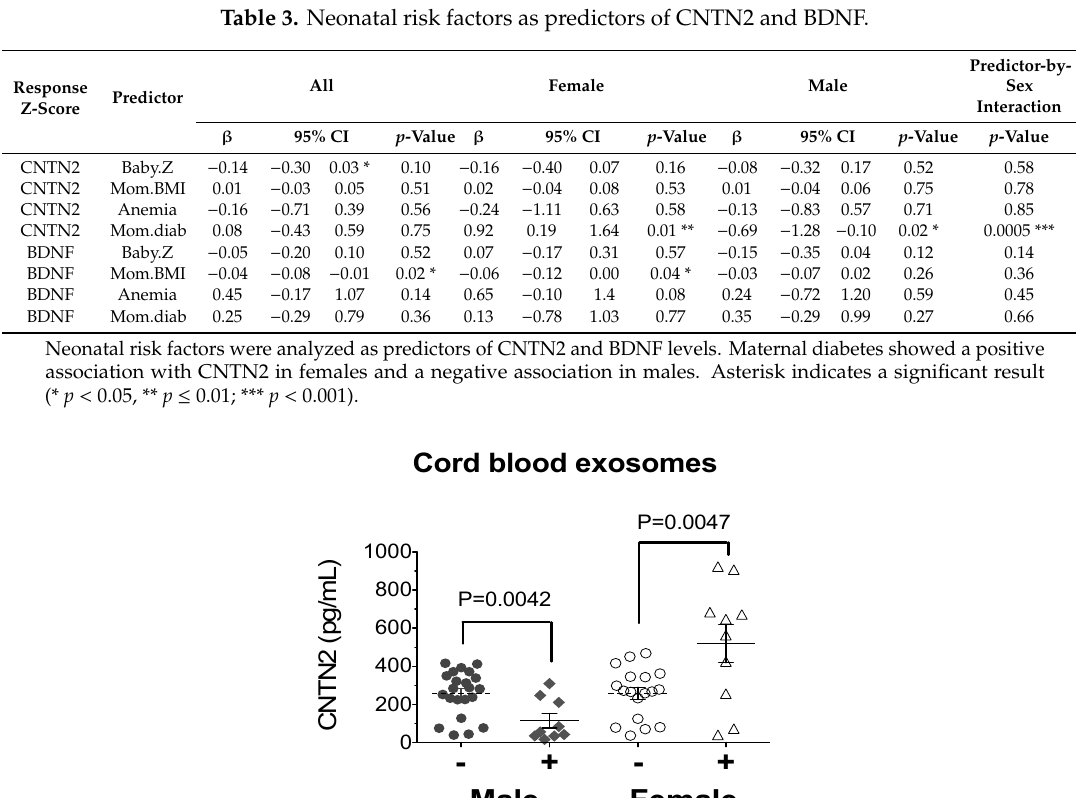
Table 3. Neonatal risk factors as predictors of CNTN2 and BDNF.